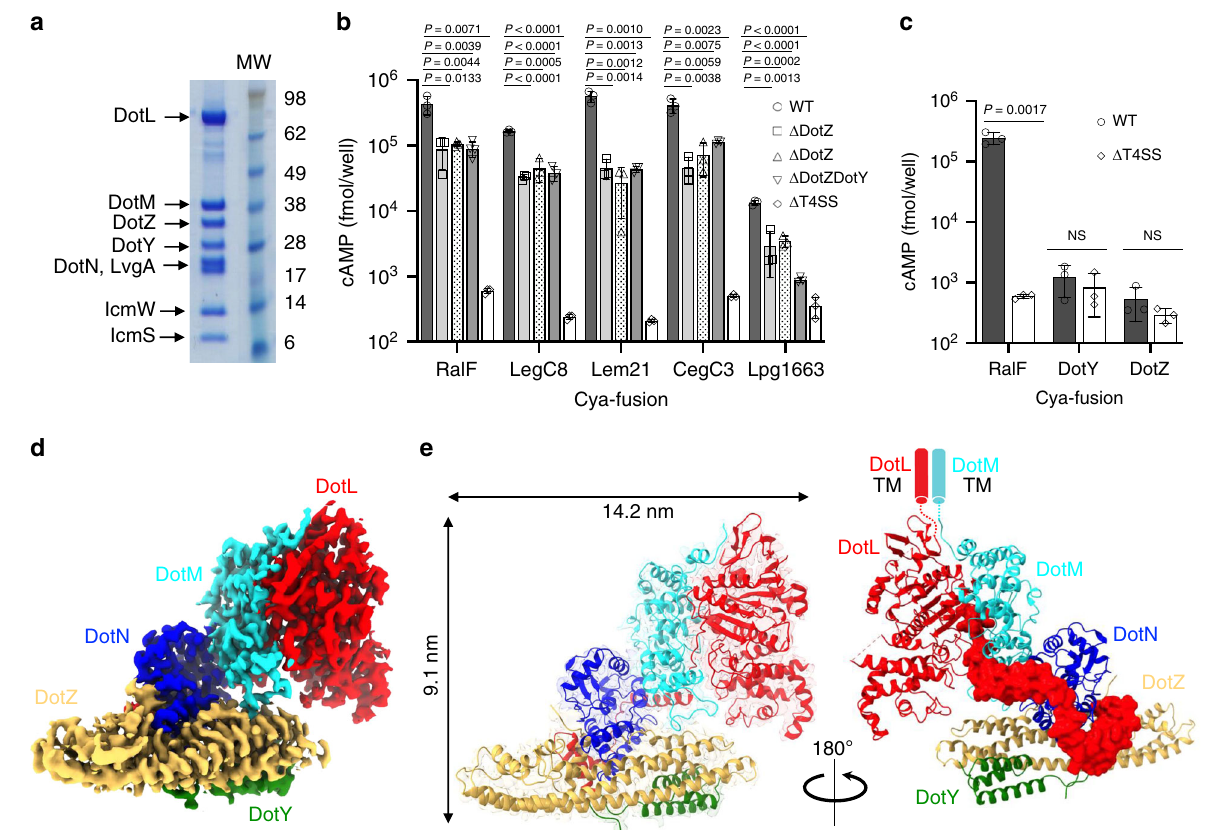
Fig. 1 Biochemical, biological and structural characterisation of the Legionella T4CC. a SDS-PAGE analysis of the puri fi ed complex. Lane 1: the T4CC, Lane MW: molecular weight markers. Protein bands were identi fi ed by mass spectrometry and are labelled accordingly. Molecular weights in lane MW are also provided. SDS-PAGE analysis of the complex was routinely carried out after each preparation (at least seven times over the course of the project) and yielded the same result. A control pull-down using an untagged version of DotL did not result in any complex being puri fi ed (result not shown). b Role of DotY and DotZ in effector translocation. Levels of translocation by the deletion mutants Δ dotY , Δ dotZ and Δ dotYZ were compared to the Lp01 wild-type strain (WT) and a strain defective in the T4S system ( Δ T4SS) 45 . Bar shape-coding for each mutant and wild-type strains is indicated on the right. For the Δ dotY , Δ dotZ , Δ dotYZ mutants, differences in translocation levels were found to be signi fi cant with a P value of <0.005 comparing to WT. Only for RalF, P values were <0.05. c Translocation of DotY and DotZ. Translocation of Cya-DotY and Cya-DotZ was compared to Cya-RalF, and also assayed in the Δ T4SS strain. Bar color-coding is shown at the top. For both Cya-DotY and Cya-DotZ, there were no signi fi cant differences in translocation levels between the WT and Δ T4SS strains. d Electron density of the T4CC hetero-pentameric core. The map was contoured at 7 σ level. Color-coding is per protein, red, cyan, blue, orange yellow and green for DotL, DotM, DotN, DotZ and DotY, respectively. e Two views of the structure of the T4CC hetero-pentameric core. The two views are related by 180° rotation. At left, DotL, DotM, DotN, DotZ and DotY are shown in ribbon, color-coded red, cyan, blue, orange yellow, and green, respectively. Electron density is as in panel d, but semi-transparent. Complex dimensions are indicated. At right, the proteins are represented in ribbon except for the C-terminal tail of DotL, which is shown in surface representation. Color-coding is as shown in the panel at left. The locations of the disordered transmembrane (TM) regions of DotM and DotL are indicated by a cyan and red cylinders, respectively, thereby providing the location of the inner membrane (IM). For ( b ) and ( c ), data are representatives of three independent experiments ( n = 3), each strain with biological triplicates. For each independent experiment, effector translocation values in mutants were normalized against their ratio to WT. Graphs report mean intracellular cAMP levels ± standard deviation for each strain. Indicated P values are mutant strains in comparison to wild-type, calculated by two-tailed Student ’ s t test. NS not signi fi cant ( P > 0.05). For ( a – c ), Source data are provided as a Source Data fi which inserts into the DotZ groove (Fig. 3g). DotM interacts with DotM interact with residues in α 1, α 1 α 2, α 3 β 3, and α 6 of DotN DotZ through an extended loop, β 1 β 2. β 1 β 2 of DotM, α 7 and α 8 (Fig. 3e and Supplementary Figs. 3b, c and 4e). of DotZ, and α 3 β 3 of DotN form a cavity (Figs. 2 and 3h and DotZ lies along the long side of the T4CC ’ s right triangle shape. Supplementary Fig. 4h). This 294 amino acid protein has an elongated structure, the core For DotY, clear density is only observed for three N-terminal of which is made of three long α -helices ( α 3, α 4, and α 7) (Figs. 2 helices ( α 1 – 3) and a substantial loop following α 3 (Figs. 2 and 3i). and 3f). Four smaller helices, α 1, α 2, α 5, α 6 wrap around the These regions of DotY are ordered because they make extensive distal end of the α 3 – 7 bundle, α 1 departing at a 90° angle to interactions with DotZ. This interface brings together residues in form together with α 3 a groove (Fig. 3f). It makes signi fi cant α 1 and α 2 of DotY with residues in α 3 and α 4 of DotZ and a contact with DotN (1517 Å 2 , the 3rd largest interface) and DotY (1396 Å 2 , the 4th largest), but engages weakly with DotM cluster of residues in the DotY α 3 loop with the DotZ groove (355 Å 2 ) and DotL (177 Å 2 ) (Supplementary Figs. 3a – e and 4d, (Fig. 3i and Supplementary Figs. 3d,e and 4g). Proximity of DotN f – h). DotN interactions with DotZ include residues of the very C- and DotY within the DotZ groove leads to interactions between terminal helix ( α 8) and residues in α 4 and the α 4 α 5 loop of DotN these two proteins (Supplementary Fig. 4i).